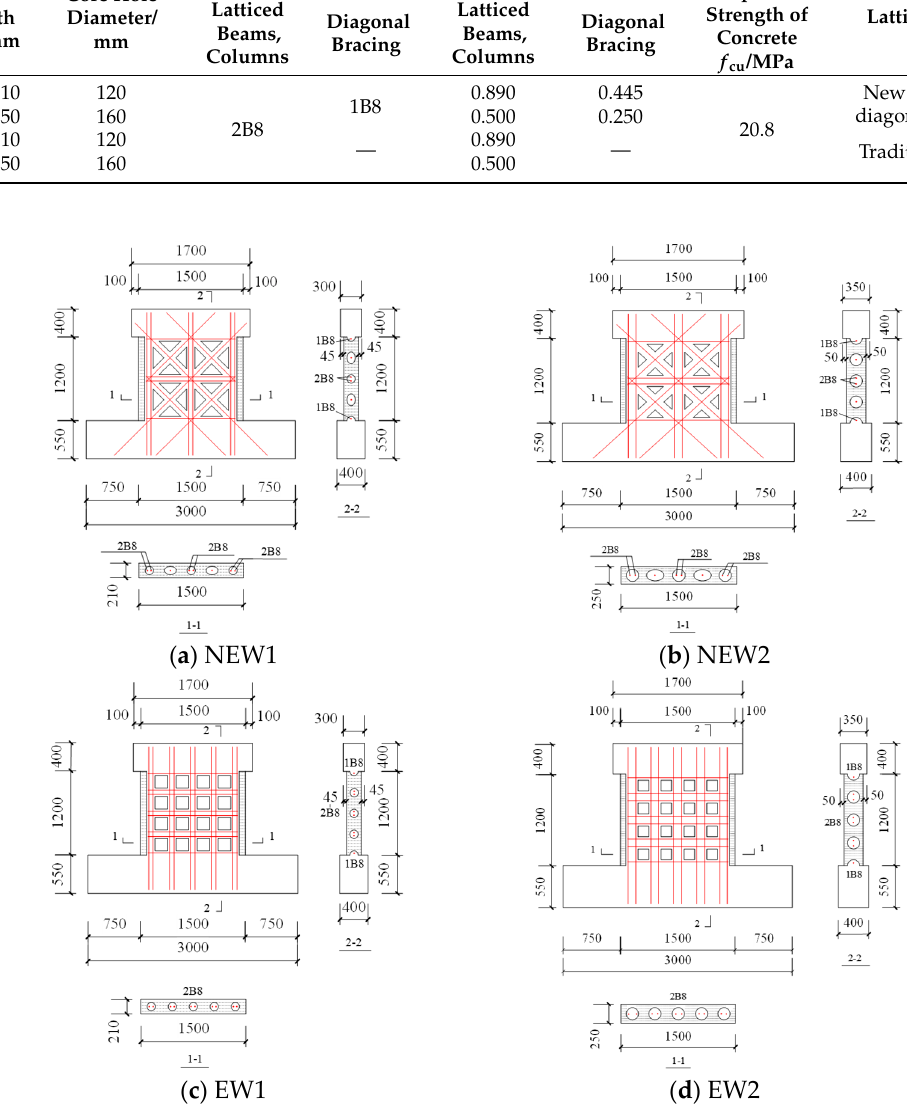
Figure 3. Wall specimen details